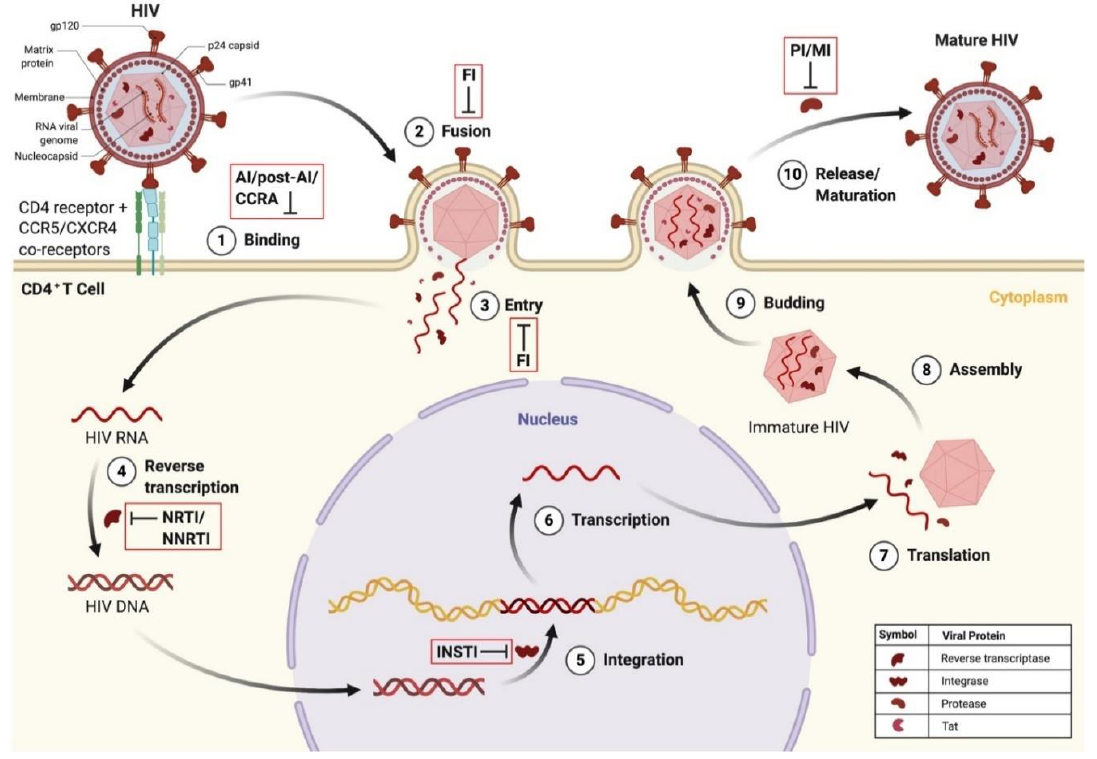
Figure 5. HIV infection of CD4 + T cell and points of ARVd intervention in the HIV replication cycle. (1) HIV binds to the CD4 receptor and CCR5/CXCR4 co-receptors. This can be blocked by attachment inhibitors, post-attachment inhibitors, and CCR antagonists. (2) Fusion of the HIV and host cellular membrane occurs. This can be blocked by fusion inhibitors. (3) Entry of viral proteins into the host cell. This can be blocked by fusion inhibitors. (4) Reverse transcription of HIV RNA into proviral HIV DNA. This can be blocked by nucleoside/non-nucleoside reverse transcriptase inhibitors. (5) Integration of HIV DNA into the host genome. This can be blocked by integrase strand transfer inhibitors. (6) Transcription of HIV RNA. (7) Translation of HIV RNA into viral proteins. (8) Assembly of immature HIV. (9) Budding of immature HIV into the host cell membrane. (10) Release and maturation of HIV. This can be blocked by protease inhibitors and maturation inhibitors. Created with BioRender.com. Abbreviations: ARVd = antiretroviral drug; CD4 = cluster of differentiation 4; CCR5 = C-C motif receptor 5; CXCR4 = C-X-C motif receptor 4; DNA = deoxyribonucleic acid; FI = fusion inhibitor; HIV = human immunodeficiency virus; INSTI = integrase strand transfer inhibitor; Tat = transactivator of transcription.